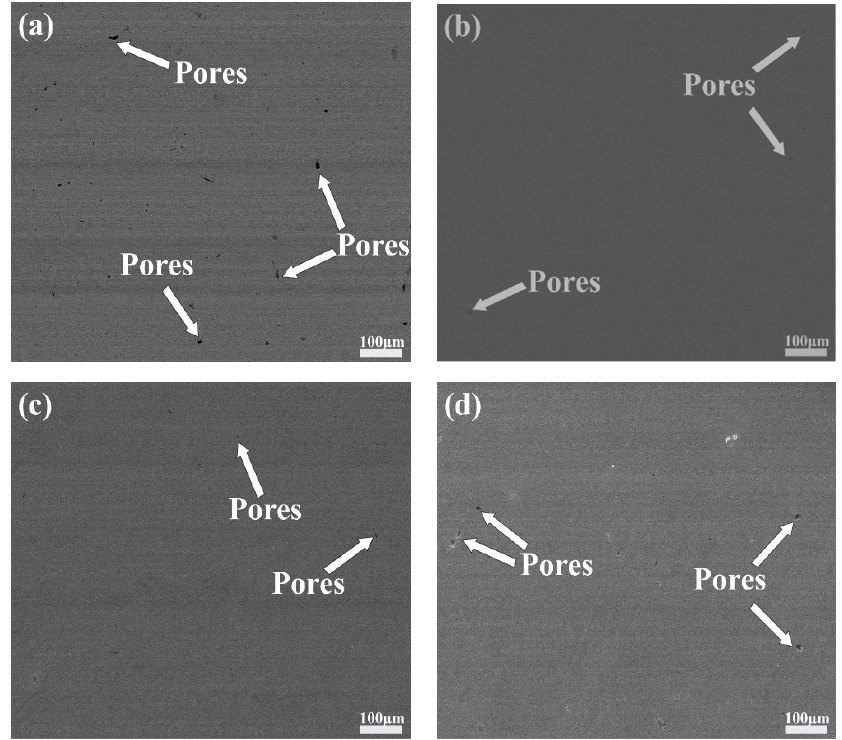
Figure 4. SEM images of ultrafine cemented carbides sintered at 1300 °C for different holding times: ( a ) 20 min; ( b ) 40 min; ( c ) 60 min; ( d ) 80 min.